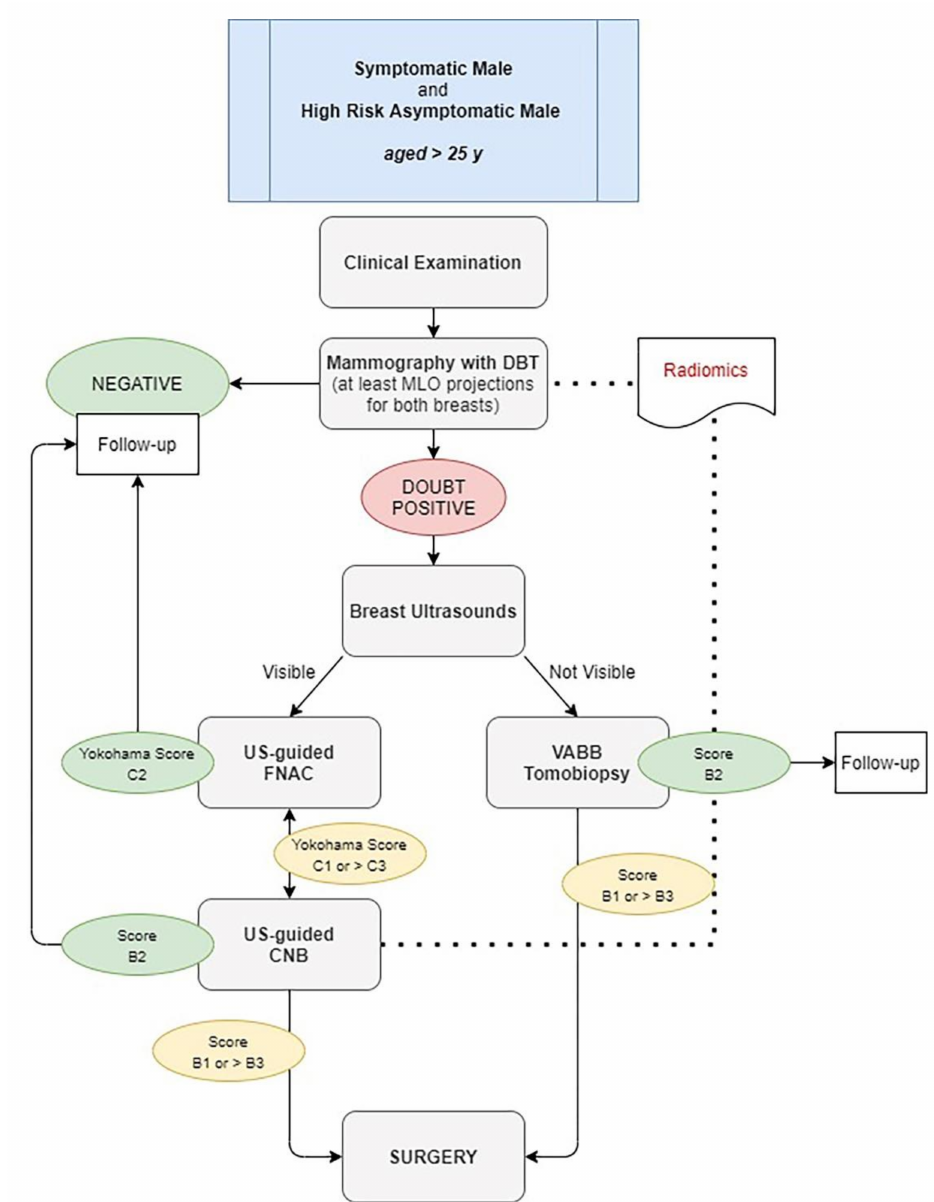
Figure 9. Diagnostic Algorithm for both symptomatic and high-risk asymptomatic male aged > 25 years. DBT: digital breast tomosynthesis. US: ultrasound. VABB: vacuum-assisted breast biopsy. FNAC: fine-needle aspiration cytology. CNB: core-needle